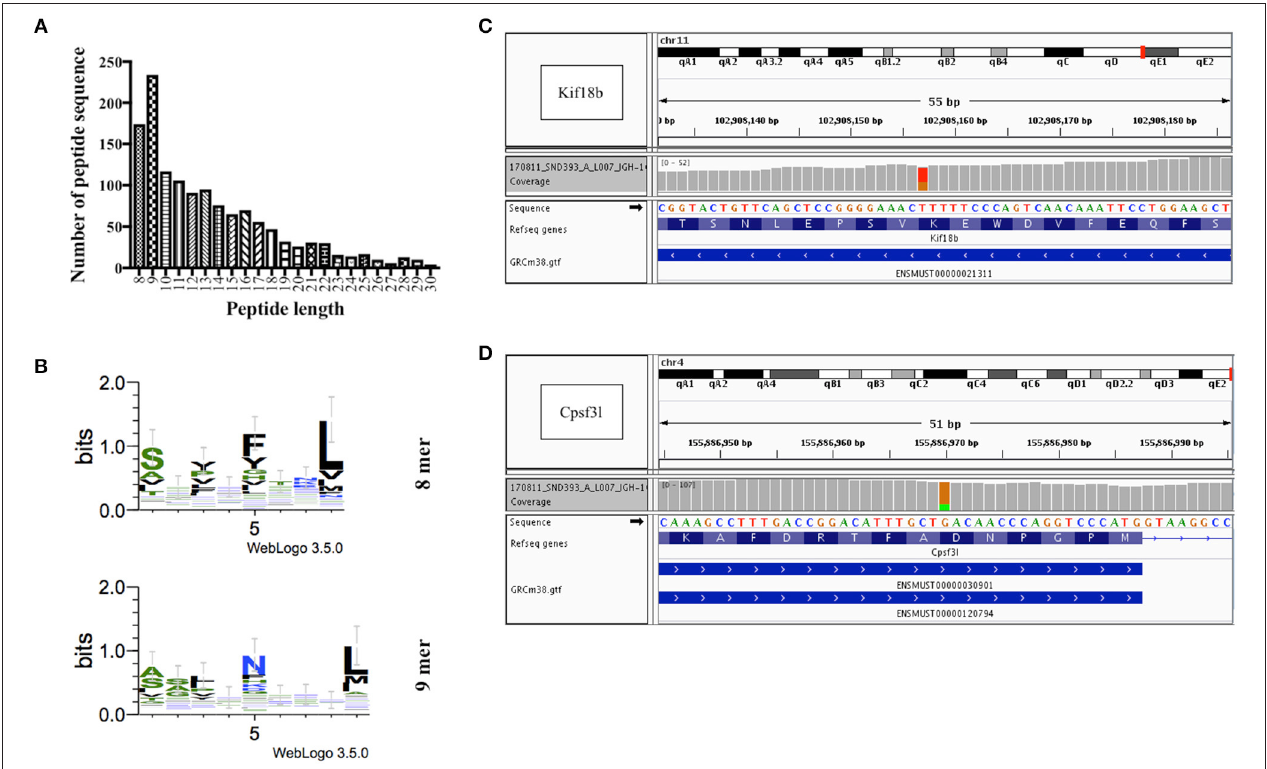
FIGURE 3 | Identification and prediction of CD8 + T-cell epitopes of B16F10 melanoma cells by immunopeptidomics and whole exome sequencing. (A) Length distribution of peptides identified by immunopeptidomics. (B) 8 and 9 mers motifs identified by immunopeptidomics. (C) Whole exome sequencing results showing a heterozygous SNV (marked in red and orange) in the 13th exon of gene Kif18b at position Chr11:102,908,157 (ENSMUST00000021311: c.2367T > G, p.Lys739Asn), causing a K > N missense mutation. (D) Whole exome sequencing results showing a heterozygous SNV (marked in orange and green) in the 9th exon of gene Cpsf3l